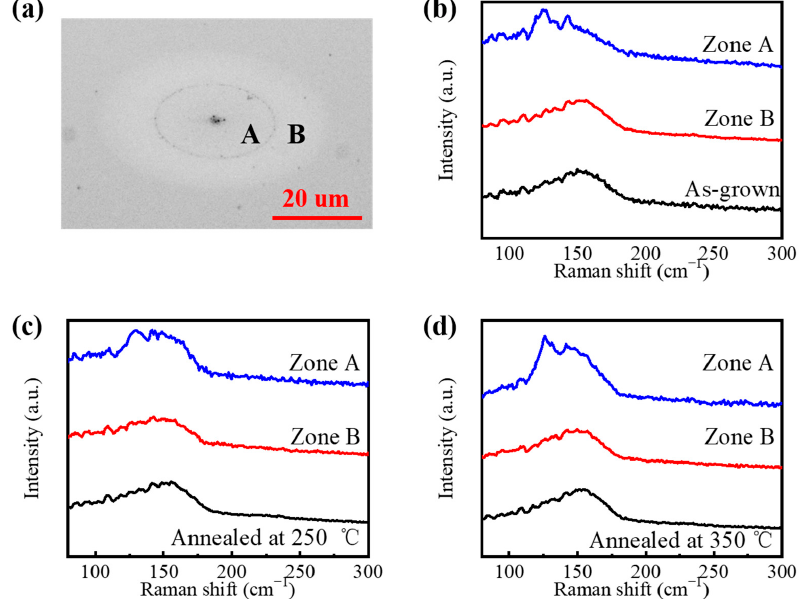
Figure 7. ( a ) Optical images of the final structures of the crystalline FCC structure films after the reflective-type pump–probe experiments, ( b ) Raman spectrum of the amorphous GST films in different regions, ( c ) Raman spectrum of the crystalline FCC structure films in different regions, ( d ) Raman spectrum of the crystalline HCP structure films in different regions.